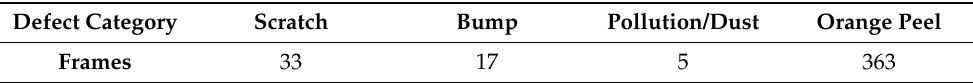
Table 5. Dataset for Defect Category and Frames based on Independent Frames.